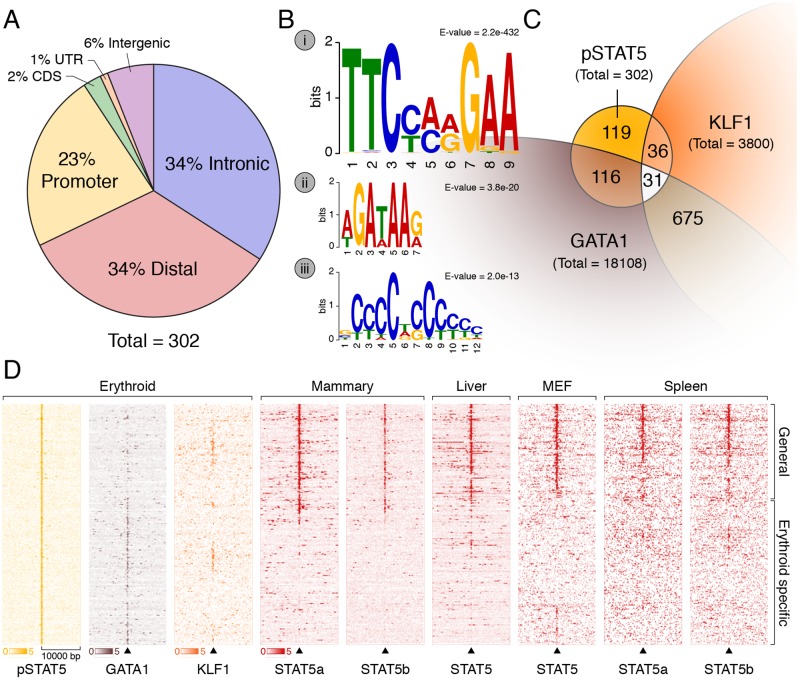
pSTAT5 binds promoters and enhancers of key erythroid genes in concert with GATA1 and KLF1.(A) 302 peaks were annotated with respect to the nearest TSS as defined by RefSeq. Only ~23% of peaks reside within gene promoters (1 kb upstream or 100 nt downstream of a TSS). The majority are intronic or distal (within 50 kb of a gene body) consistent with enhancer occupancy. (B) De novo motif discovery on all 302 peaks using MEME (see Methods) identified highly significant enrichment of a (i) palindromic GAS element (TTCYMRGAA), a (ii) GATA binding site (WGATAR), and a (iii) KLF binding site (CCMCRCCCN). No other significantly enriched motifs were found. (C) Venn diagram and of erythroid co-occupancy between pSTAT5, KLF1 and GATA1 at key erythroid enhancers and promoters. KLF1 ChIP-seq was generated in K1-ER cells and GATA1 ChIP-seq was generated in G1-ER4 cells after induction with tamoxifen. Co-occupancy defined as ChIP summits within 500 bp. (D) Density heat-map of ChIP signal centred on pSTAT5 peak summits from GATA1 and KLF1 as above (C) and additional STAT5 ChIP in other murine tissues. The Y-axis represents individual peak regions, and the X-axis represents 10 kb surrounding the summit. Read intensities were normalized to number of reads in dataset and hierarchically clustered according to intensity within 500 bp of peak centre.